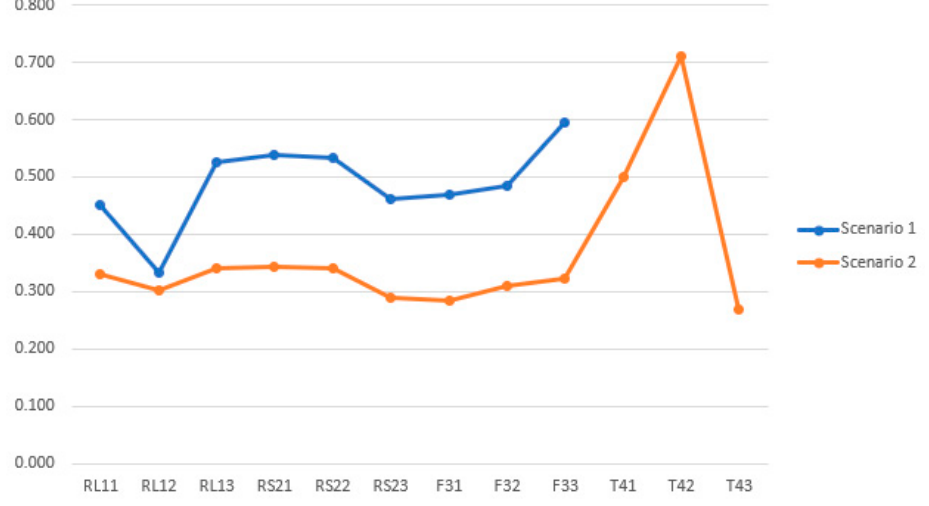
Figure 10. Final ranking score for scenarios 1 and 2.